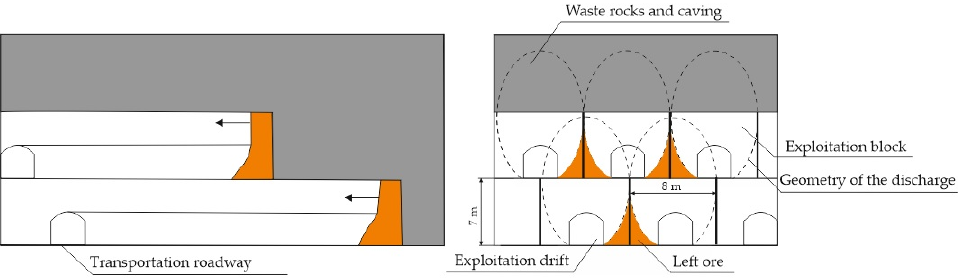
Figure 14. Sublevel caving used in the Olkusz–Pomorzany mine in Poland. The layers were mined with blocks/stopes exploited from top to bottom. In the axis of each block, mining drifts with dimensions of 3 × 3 m were driven on the floor of the layer, and they were protected using rock bolt support. In the lower layers, the blocks were moved by half their length between the axes of the drifts, which ensured the recovery of the ore left in the leftovers between the mining drifts in the upper layer. The length of the exploitation blocks did not exceed 100 m.